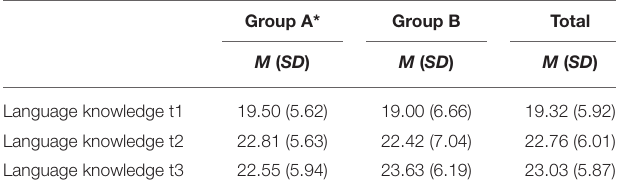
TABLE 4 | Performance cued recall of Song B (max. 36): means and standard deviations for both conditions and time-points. Sung